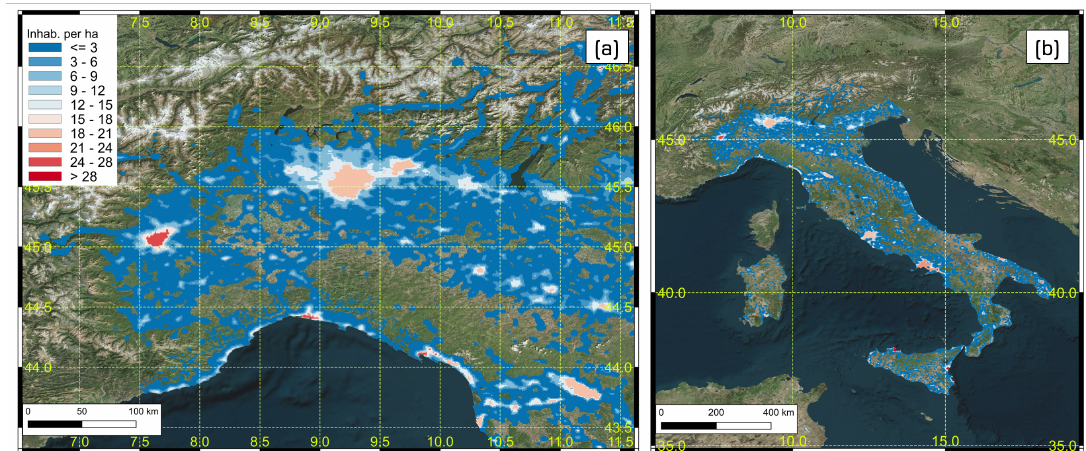
Figure 7. Estimated population distribution obtained redistributing regional population data from ISTAT on the urban density map derived from DMSP, detailed for North-West Italy ( a ) and distributed for all of Italy ( b ).